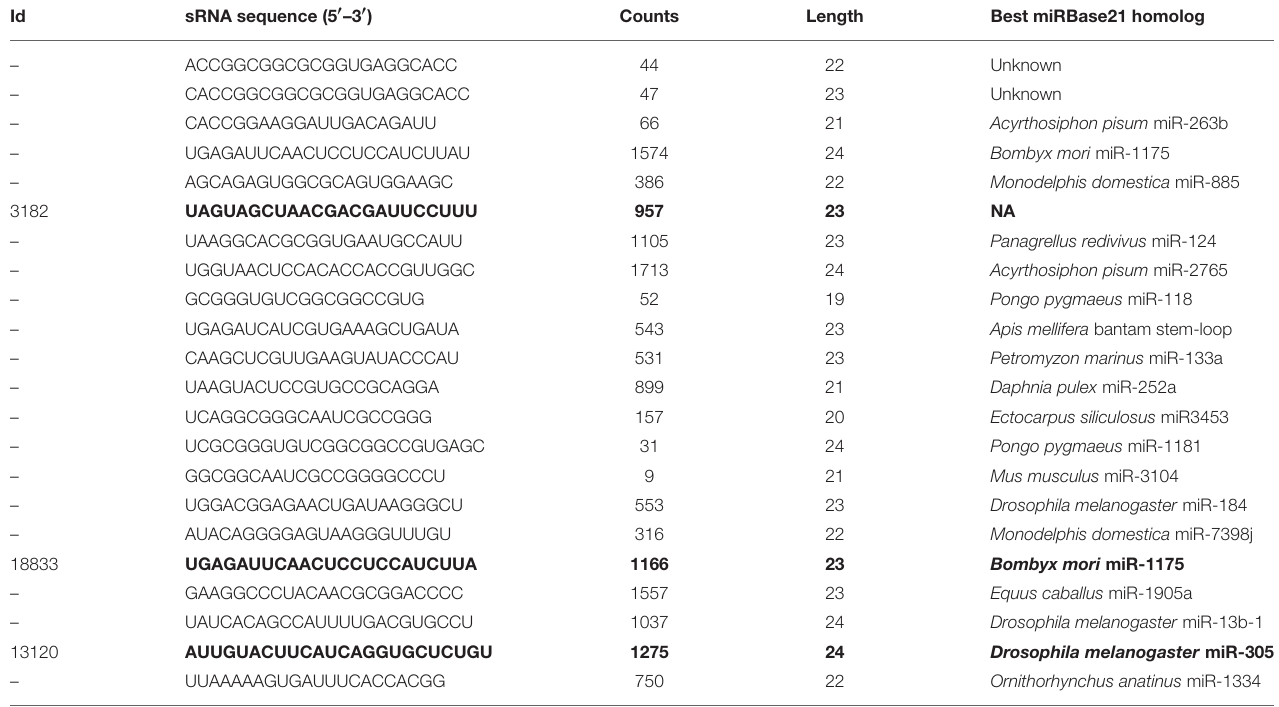
The sRNAs indicated in bold were detected with stem-loop RT-PCR.